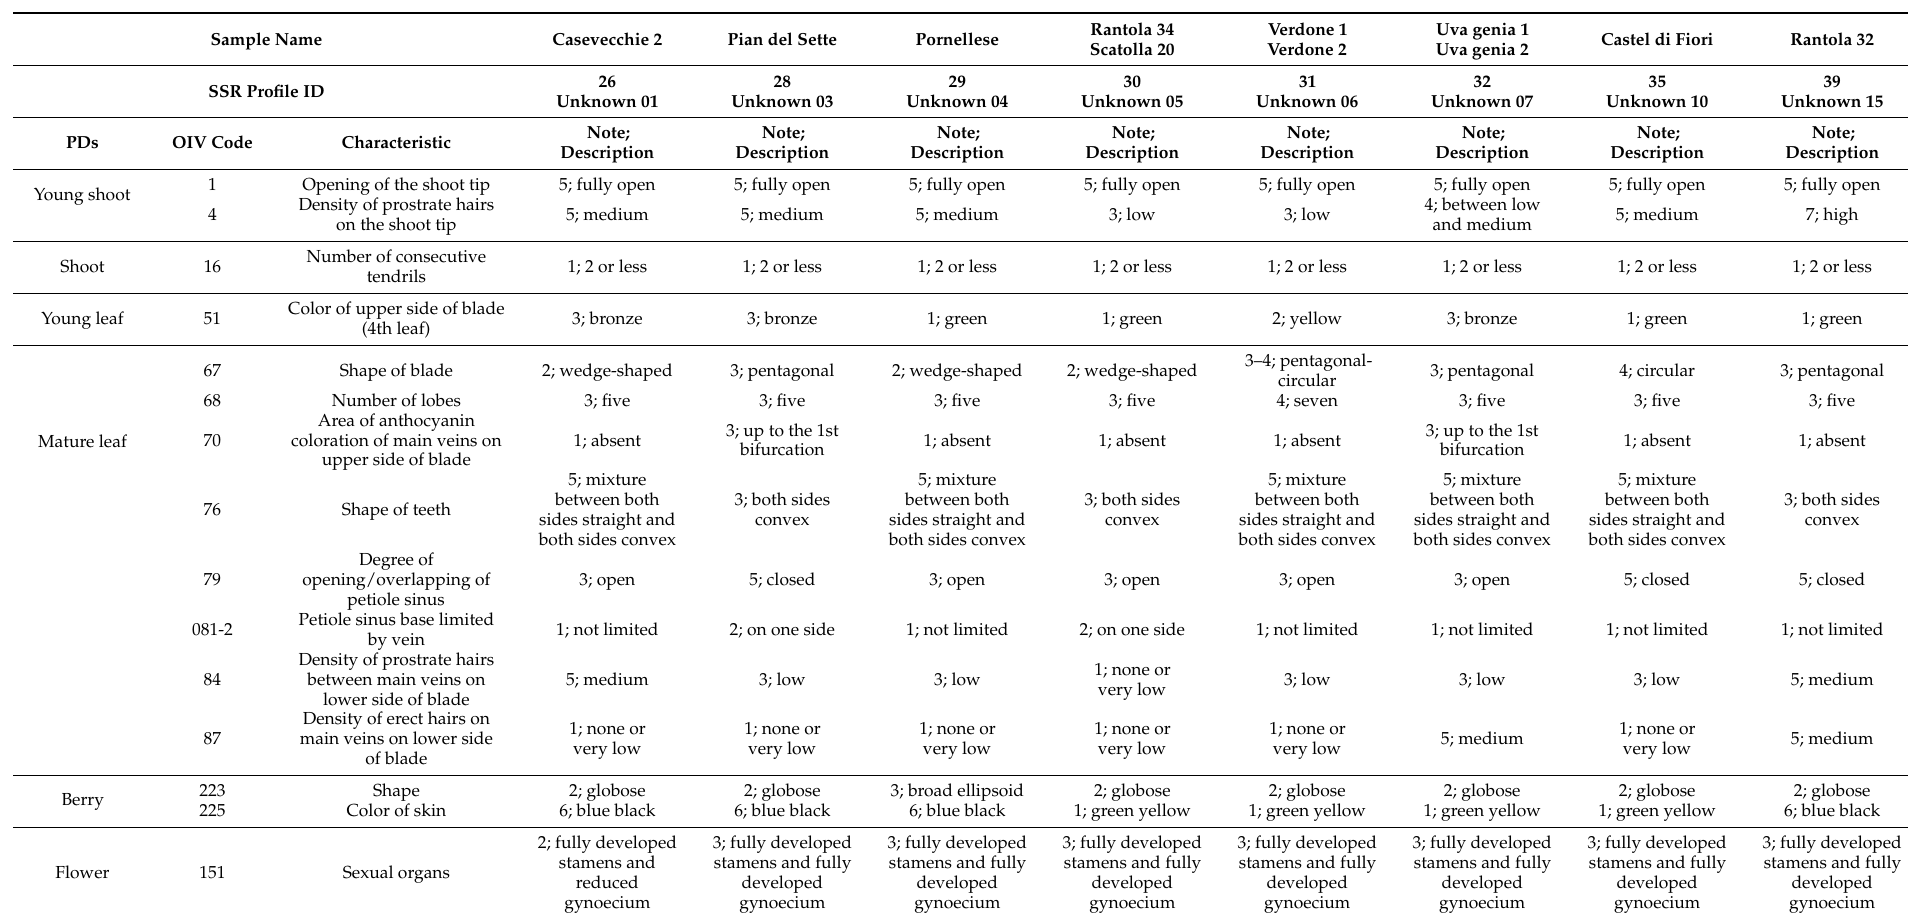
Table 4. Ampelographic descriptions of 11 grapevine accessions belonging to eight different unknown genotypes present in the vineyard germplasm collection at Castello di Montegiove Estate, municipality of Montegabbione (TR). The set of 14 standardized OIV primary descriptor (PDs) plus OIV 151, grouped according to each target vine organ (young shoot: OIV 001, 004; shoot: OIV 016; young leaf: OIV 051; mature leaf: OIV 067, 068, 070, 076, 079, 081-2, 084, 087; berry: OIV 223, 225; flower: OIV 151), are shown for each SSR